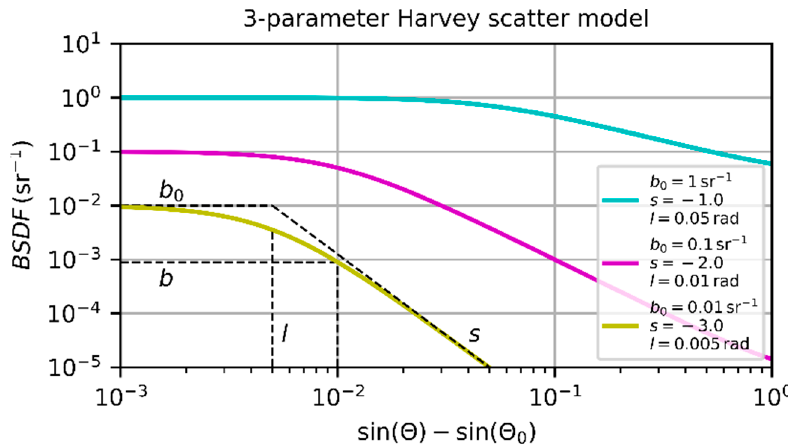
Figure 2. Bidirectional scattering distribution function according to the 3-parameter Harvey scatter model for different sets of scatter parameters.